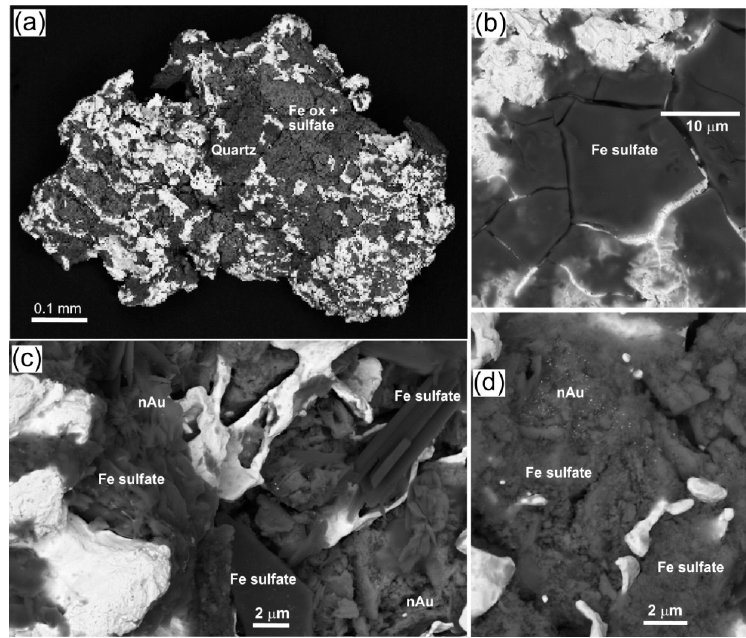
Figure 7. SEM backscatter electron images of surface features of proximal detrital gold in Late Pleistocene-Holocene sediments derived from the Macraes orogenic deposit. ( a – d ) Authigenic gold is intergrown with evaporative Fe oxyhydroxide and Fe sulfate deposits at a range of scales including nanoparticulate gold (nAu).